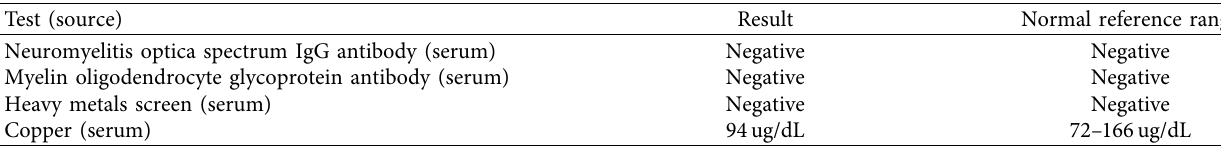
Table 2: Relevant cerebrospinal fluid (CSF) and serologic studies sent at second presentation, approximately two years after initial onset of